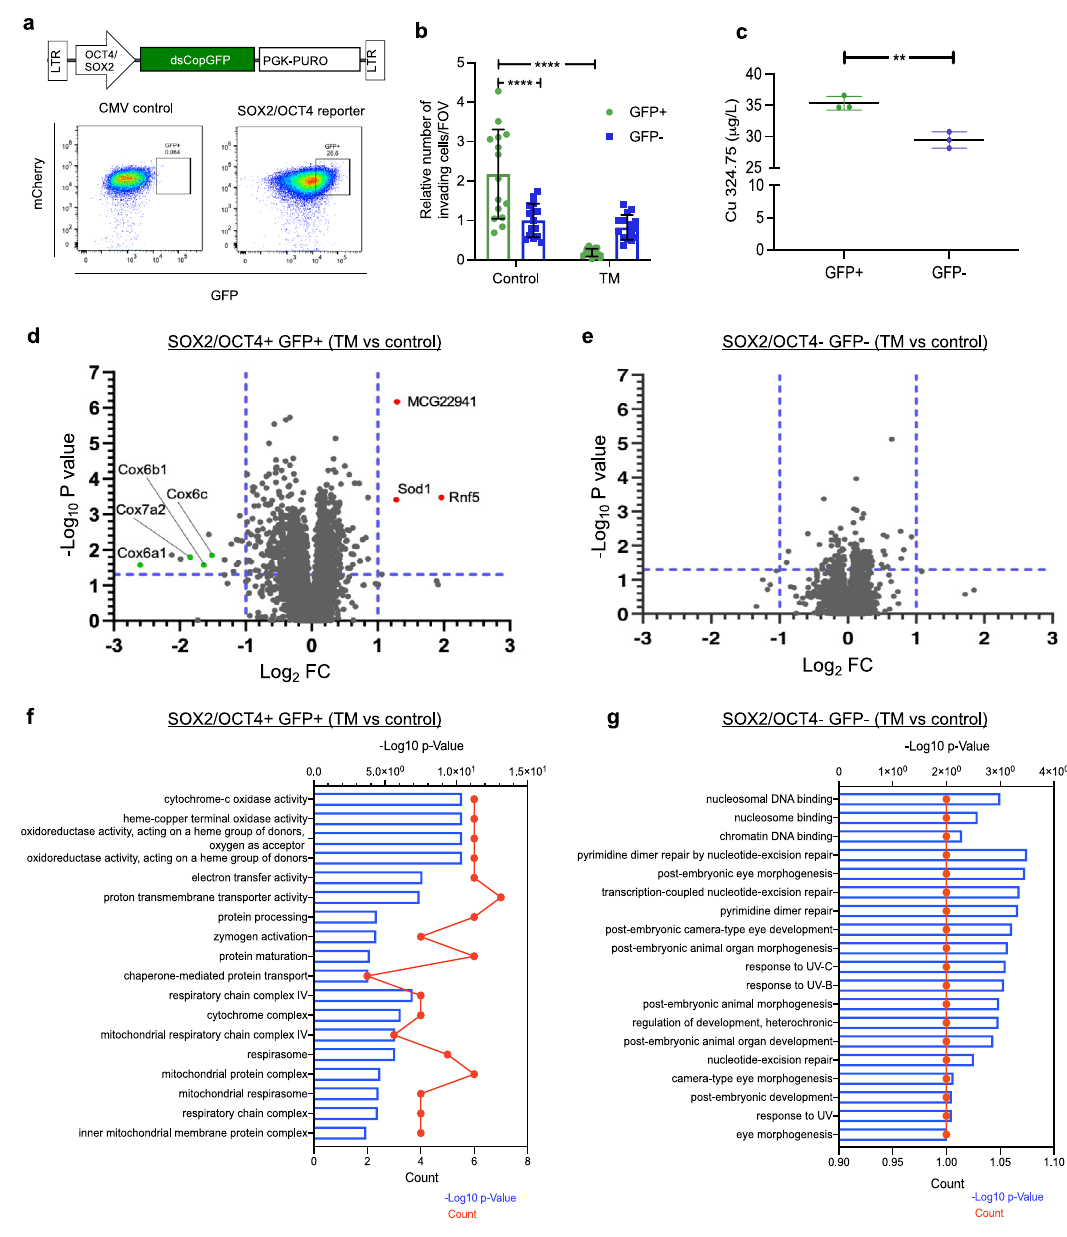
Fig. 2 Copper depletion targets SOX2/OCT4 + metastatic cells. a (Top panel) schematic of lentivirus-based SOX2/OCT4-GFP promoter-reporter system. (Bottom panel) Flow-sorted GFP + and GFP − cells from bulk ML1 cells with CMV control or SOX2/OCT4 reporter system. b Impact of TM (0.5 µ M) on the invasion of SOX2/OCT4 + GFP + and SOX2/OCT4 − GFP − cells across a matrix coated transwell in LM2 cells. Signi fi cance was calculated using Two-way ANOVA ( n = 3 replicates/group, 5 fi elds of view/sample). c Intracellular copper (Cu) levels in SOX2/OCT4 + GFP + vs. SOX2/OCT4 − GFP − cells measured by atomic absorption spectrometry ( y -axis refers to Cu content measured at 324.75nm wavelength) in ML1 cells. Analysis was performed by unpaired two-sided t -test. p -value = 0.0040. d Tandem mass tags (TMT) isobaric label multiplexed quantitative proteomic analysis of vehicle and TM (0.5 µ M) treated ML1 SOX2/OCT4 + GFP + reporter cells. Proteins with absolute log2 Fold Change (FC) > 1, p < 0.05 and FDR < 0.05 are shown in green and labeled, n = 5/group. Signi fi cance was calculated using multiple t -tests, p values were adjusted for multiple comparisons. e Tandem mass tags (TMT) isobaric label multiplexed quantitative proteomic analysis of vehicle and TM (0.5 µ M) treated ML1 SOX2/OCT4 − GFP − cells. Proteins with log2 > 1 or < − 1 and p < 0.05 are shown, n = 5/group. Signi fi cance was calculated using multiple t -tests, p values were adjusted for multiple comparisons. f and g Gene ontology (GO) analysis of downregulated proteins ( p < 0.05, average log2 < − 0.6) after 48 h TM treatment in ML1 SOX2/ OCT4 + GFP + ( f ) and ML1 SOX2/OCT4 − GFP − g cells (log2 fold change from − 2.6 to − 0.7). log2 fold change is log2 FC of TM 48 h/Control. Count refers to how many genes/proteins showed up in that GO term. GO analysis was performed using the clusterPro fi ler R package, p values were adjusted using Benjamin – Hochberg method. dsCop destabilized copepod. Representative data of two independent experiments are depicted. Results are expressed as mean ± SD. ** p < 0.01 **** p <